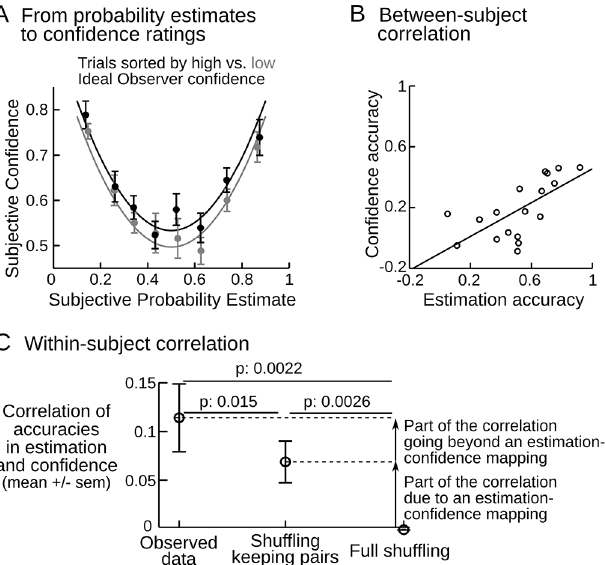
Fig 5. Evidence that probability estimates and confidence derive from a single process. (A) Subjective confidence is higher for extreme estimates of transition probabilities. The fitted lines correspond to the average of the quadratic fits performed at the subject level: confidence ~ constant + (probability estimate- 0.5) 2 . Trials were sorted by subjective probability estimates and, within each bin, into high and low Ideal Observer confidence according to a median split. Equally-filled bins were used for data visualization, not for data analysis. (B) The accuracies of probability estimates and confidence ratings are correlated across subjects. The accuracy of probability estimates was computed per subject as the correlation (across trials) of the subject's and the Ideal Observer's estimates. The same logic was used for confidence. One dot corresponds to one subject. (C) The link between probability estimates and confidence ratings goes beyond any mapping. Within each subject, we computed the correlation across trials between accuracies in probability estimates and confidence ratings. The accuracy of probability estimates was computed at the trial level as the distance between the subject's and the Ideal Observer's estimates. The same logic was used for confidence. The observed results are contrasted to two ways of shuffling the data (p-values are from one- tailed t-test, see